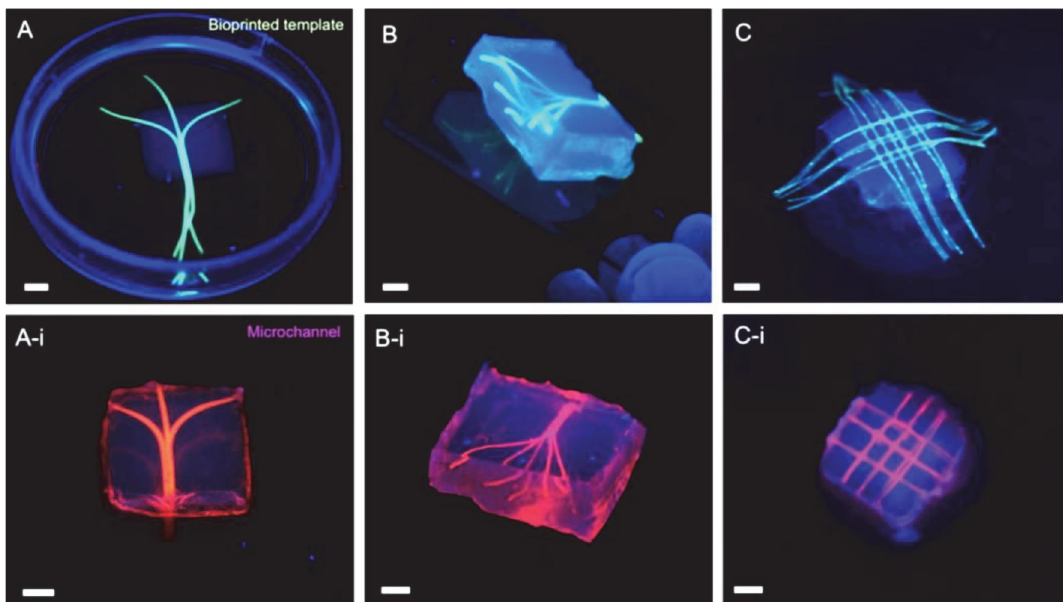
F IGURE 8: The bioprinted templates (green) are encased in GelMA hydrogels, and fl uorescent microbead suspensions are perfused through the microchannels (pink). (A) Bifurcating planar bioprinted templates in a GelMA hydrogel construct and corresponding (A-i) postperfusion networks. (B) The 3D branching agarose templates embedded in the GelMA hydrogel construct and (B-i) the resulting 3D branching network. (C) GelMA hydrogel with a 3D lattice template inside it, and the results (C-i) before and after